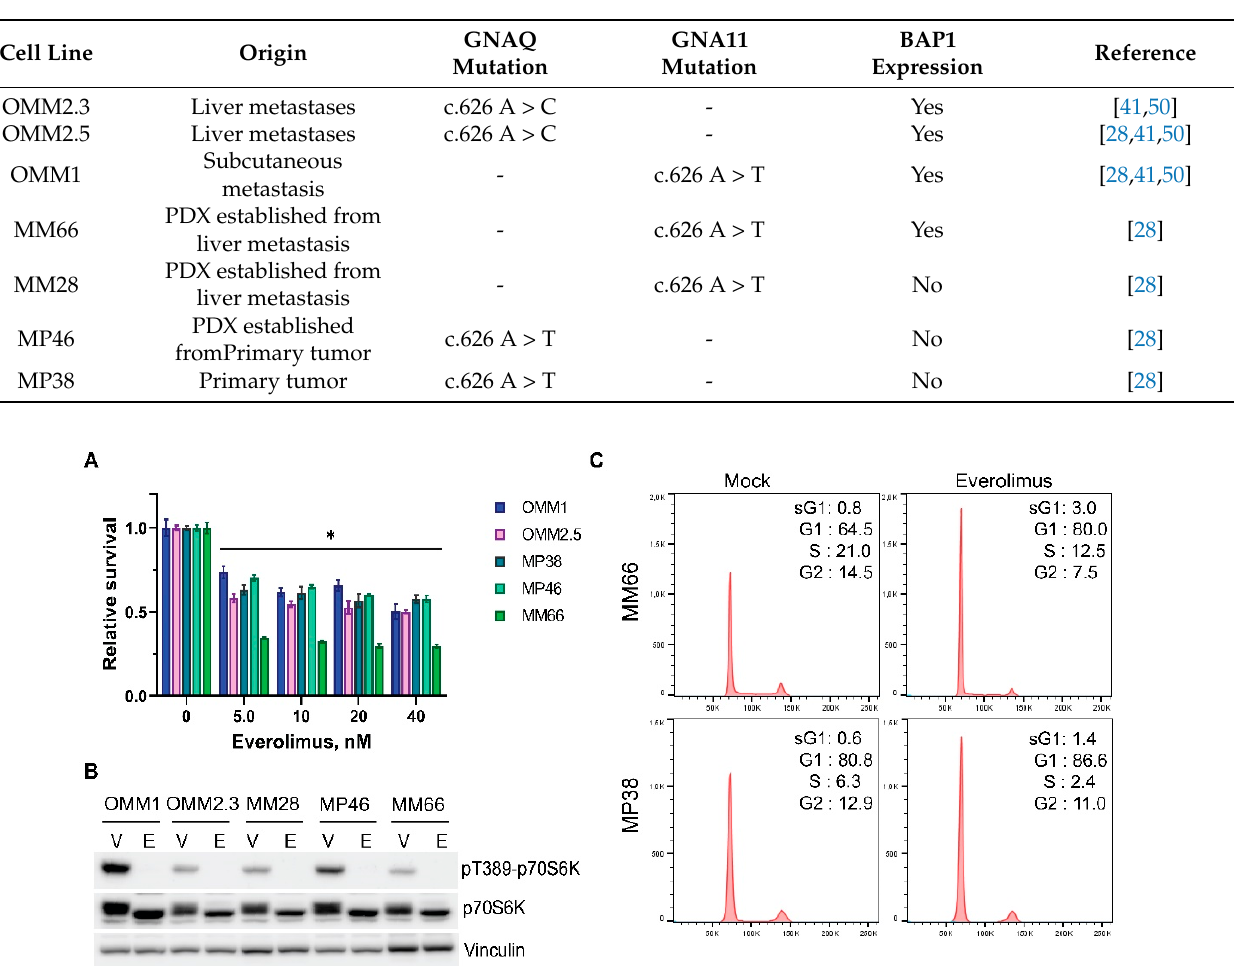
Figure 1. Everolimus inhibits growth of uveal melanoma cell lines by imposing a G1 cell cycle arrest.